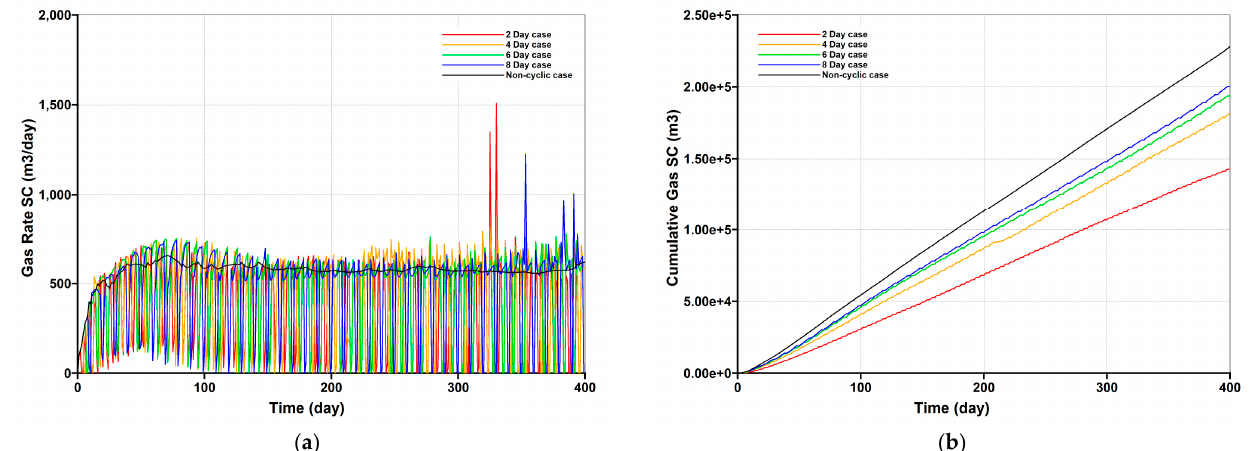
Figure 11. Results of gas production by use of different production time during primary depressurization stage: ( a ) gas production rate and ( b ) cumulative gas production.